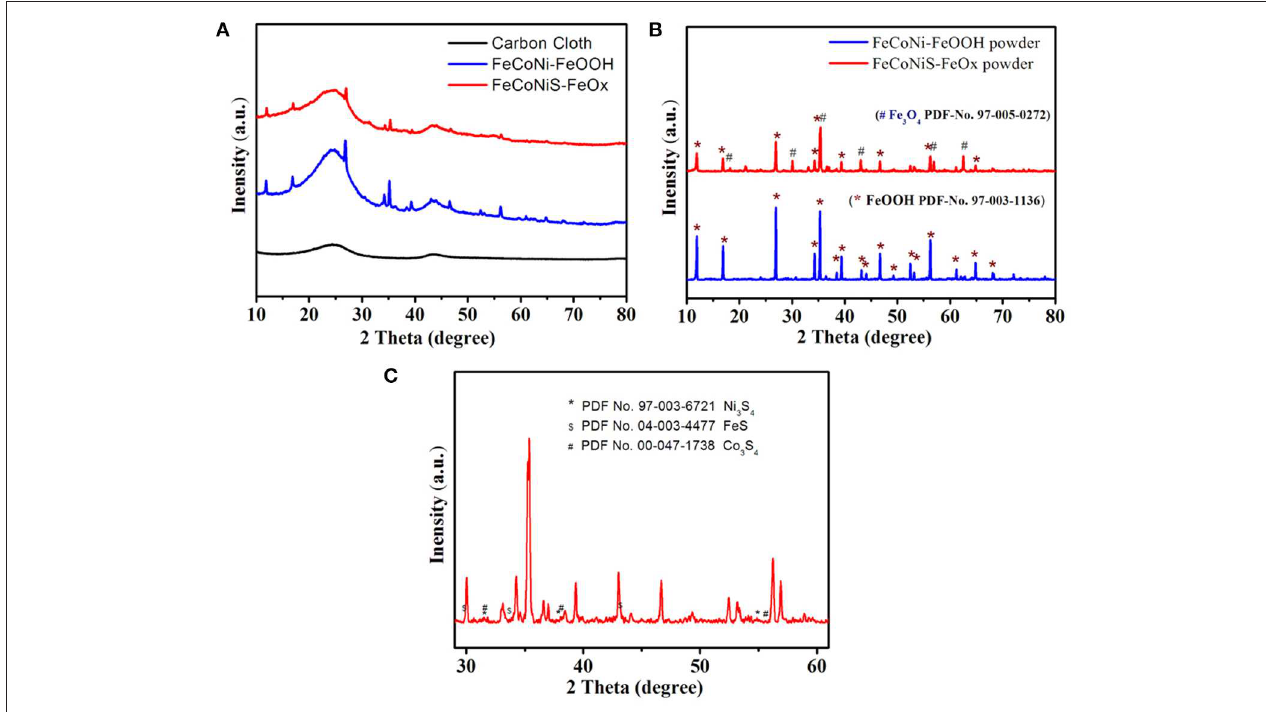
FIGURE 1 | (A) X-ray diffraction (XRD) patterns of different oxygen evolution reaction (OER) catalysts. (B) XRD patterns comparison of different catalysts powder. (C) XRD pattern of the product after sulfidation